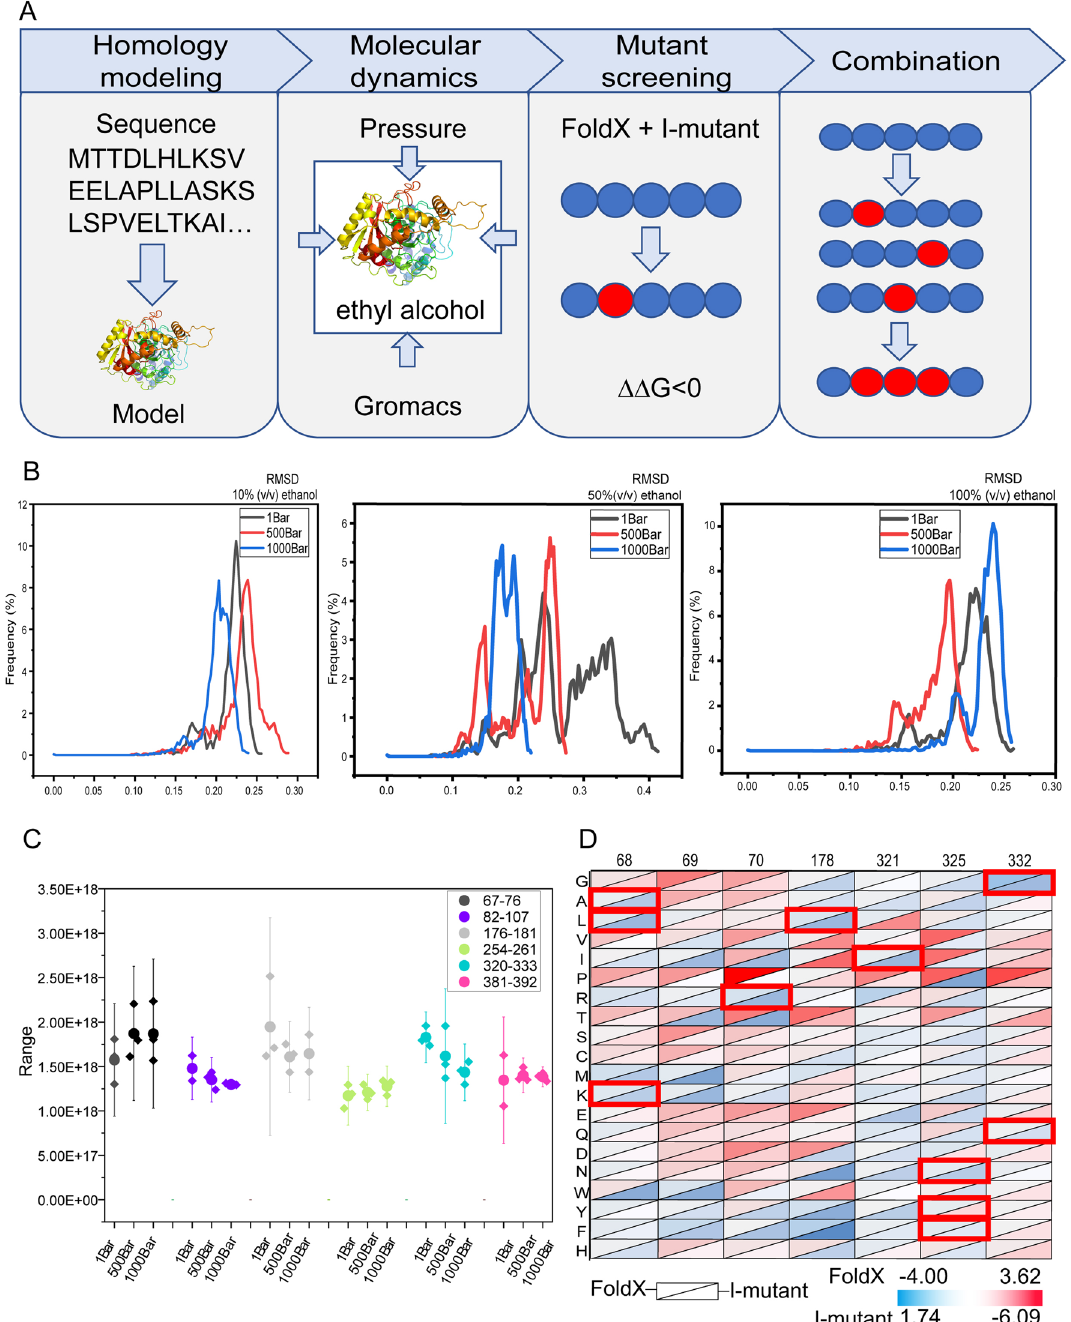
Fig. 1 Mutant screening process. A Experimental procedure for screening mutants by modelling and simulating protein sequences and validating them in experiments. B RMSD of proteins at different ethanol concentrations and different pressures (10%, 50%, 100% ethanol concentrations, 1, 500, 1000 bar). C Compression coefficients of individual protein structures at different ethanol concentrations and different pressures. Each group represented a different loop structure, each line in the group represented a different pressure in the simulated environment, and each point on the line represented β T at different ethanol concentrations. D Heat map of free energy changes at mutant sites obtained from multi-scale free energy calculations, the red box in the figure is the final selected results of the